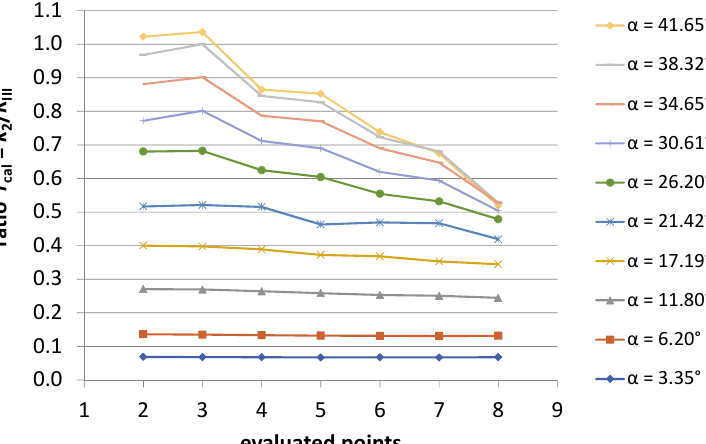
Figure 4: Results of r cal for different asperity angles α in the range from 3.35° to 41.65° in points showed in Fig.